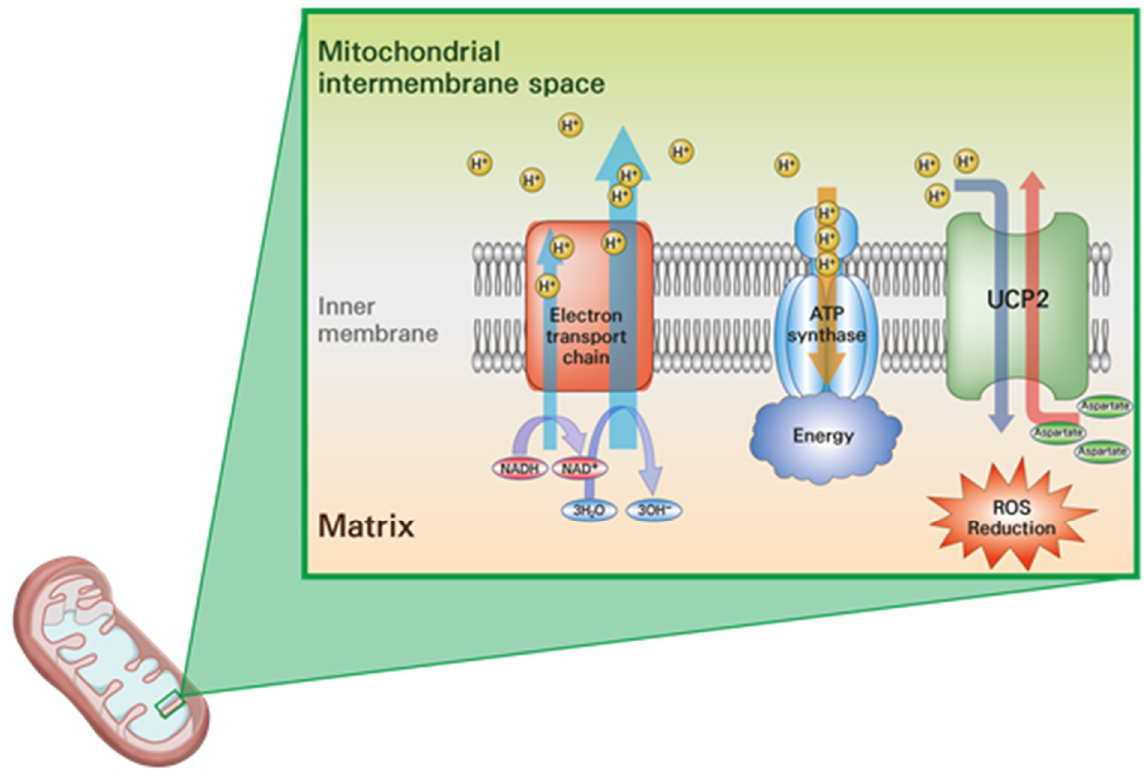
Figure 1. Schematic diagram of the function of uncoupling protein 2 (UCP2) as an uncoupler and an aspartate transporter in the mitochondria of cancer cells (Abbreviations: ATP: adenosine triphosphate; ROS: reactive oxygen species; NAD: nicotinamide adenine dinucleotide).